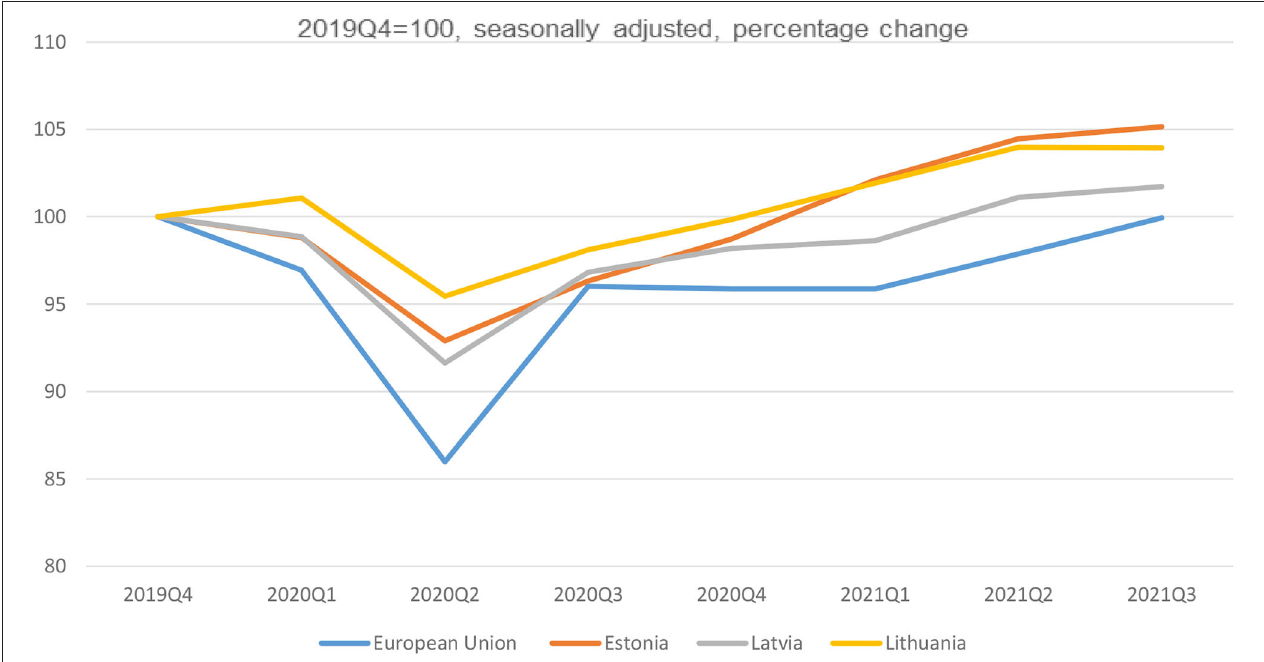
FIGURE 7 | Growth rates of GDP in Baltic states and the EU (16). Source: author’s construction based on the Eurostat data, 2021.